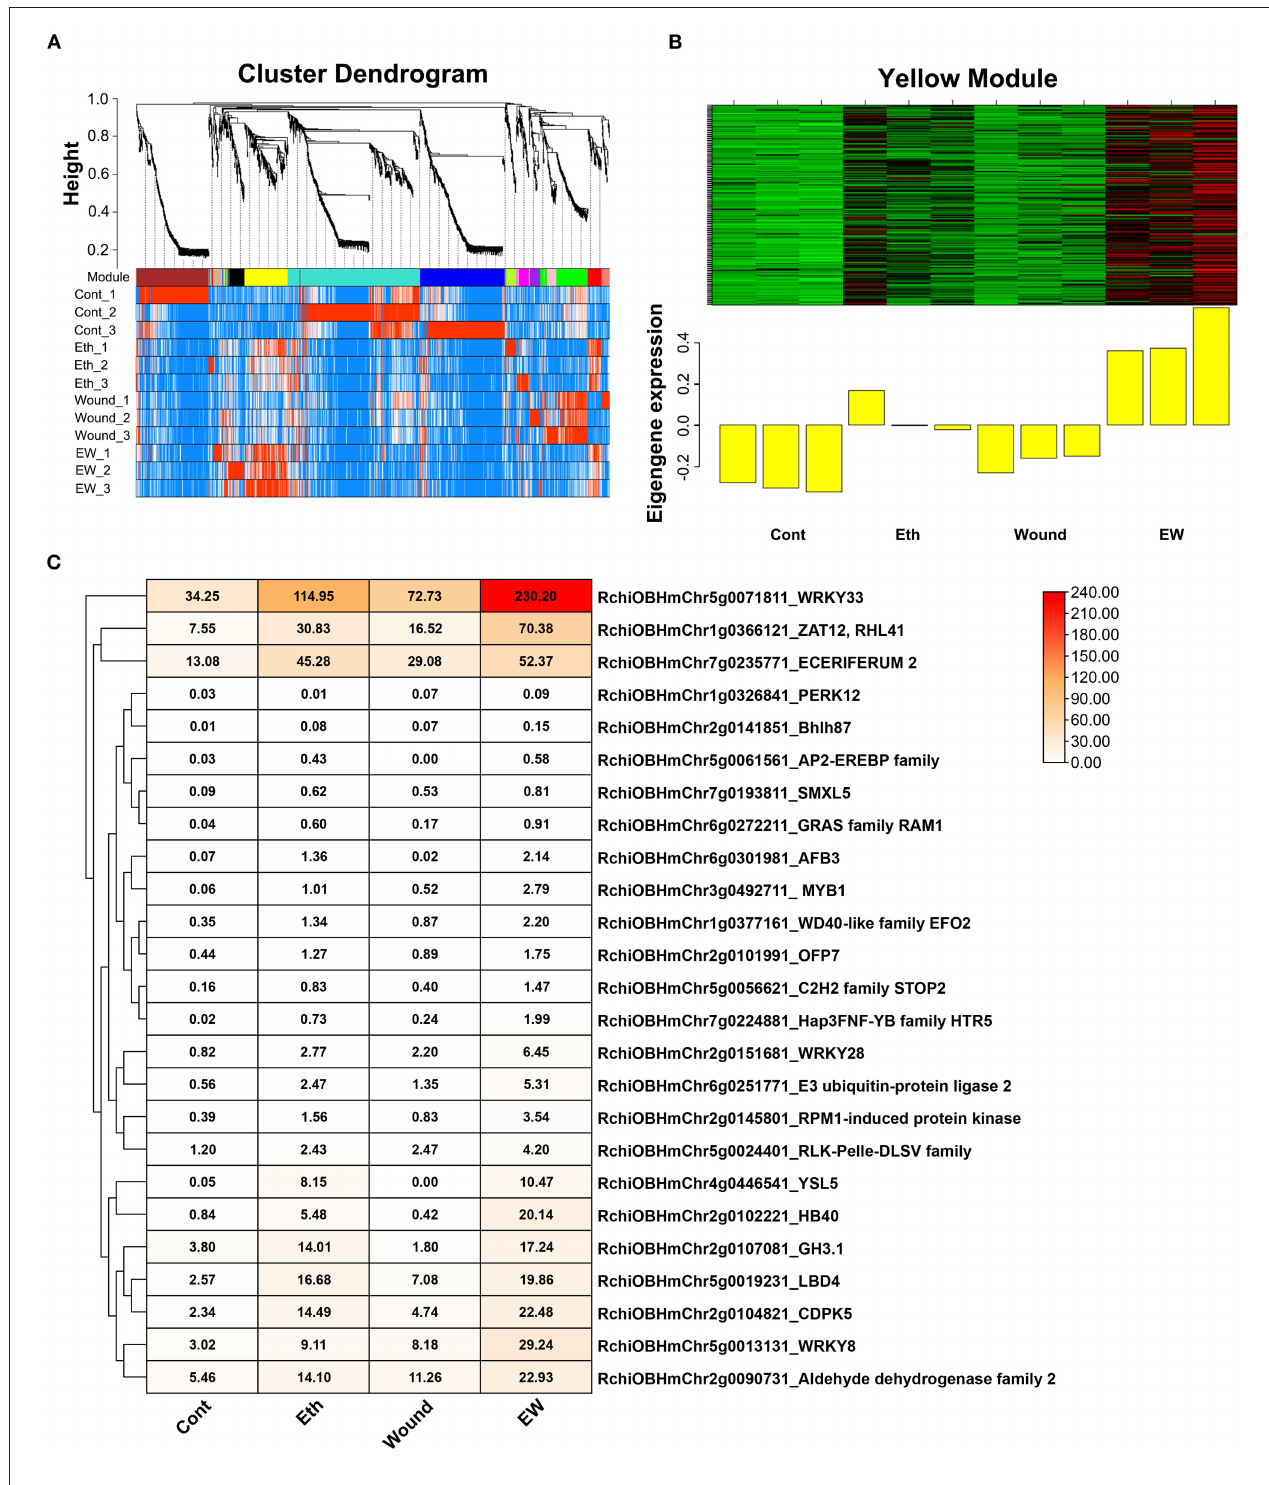
FIGURE 4 | Co-expression network analysis of DEGs involved in wound and ethylene signaling. (A) Clustering dendrogram of genes across all samples, with dissimilarity based on the topological overlap, together with assigned merged colors and original module colors. (B) Heatmap of the eigengene expression in the “yellow” module in response to wound and ethylene signaling. (C) Expression profile of screened hub genes in different treatments.